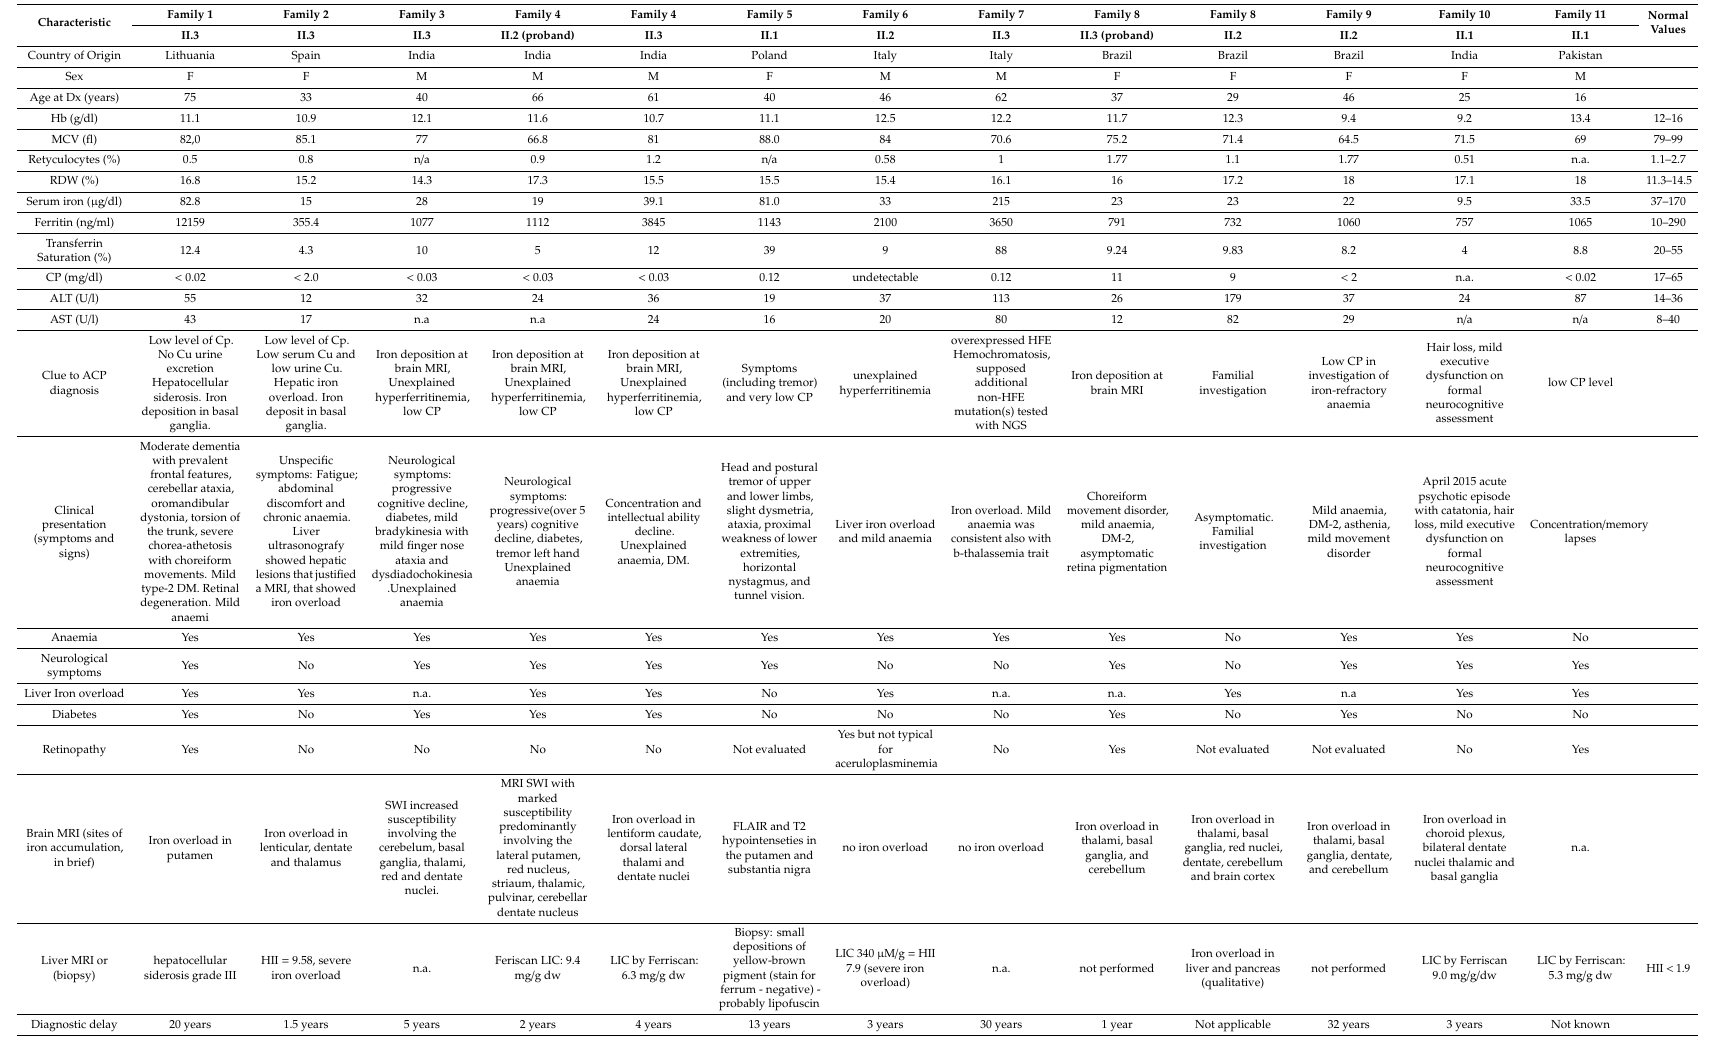
Table 1. Biochemical, clinical, and genetic data of the 13 a ff ected members in the 11 studied families with